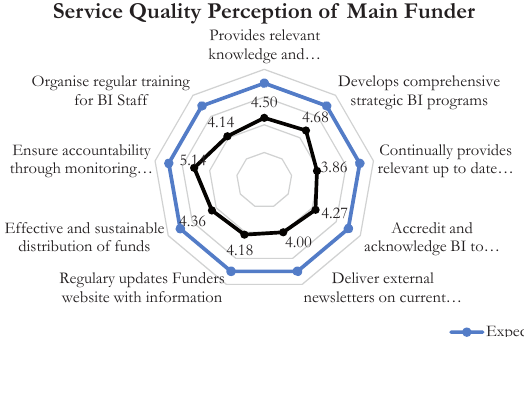
Fig. 6 – Service Quality Perception of Main Funder. Source: